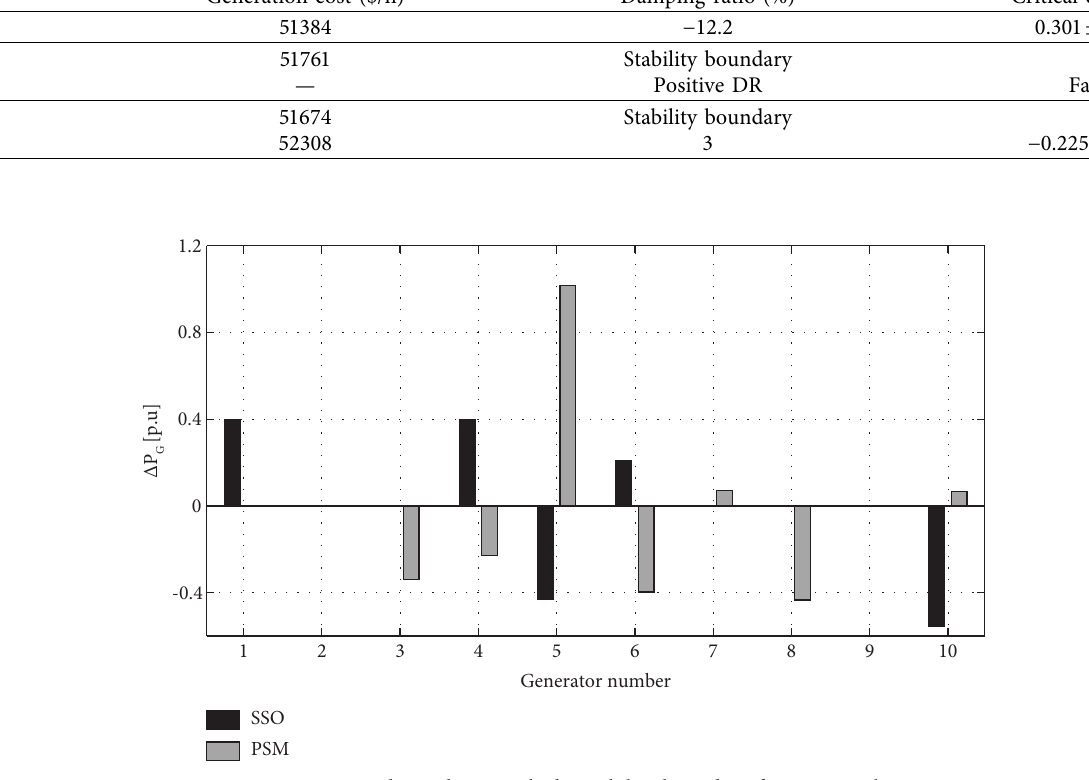
Figure 10: Generation redispatch to reach the stability boundary for IEEE 39-bus